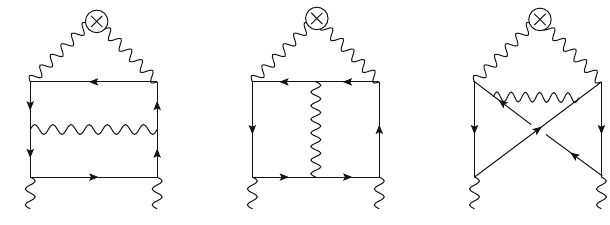
Fig. 5 Single box diagrams SB 1 - SB 3